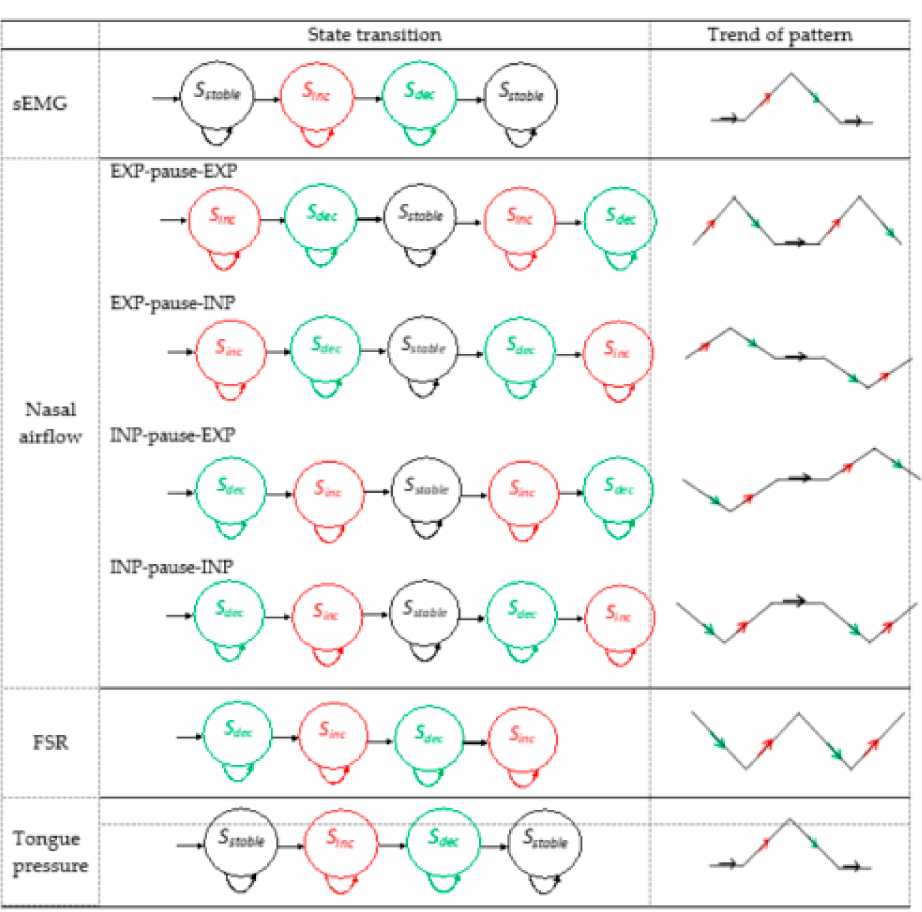
Figure 6. State transition patterns of surface electromyography (sEMG), nasal airflow, force-sensing resistor, and tongue pressure